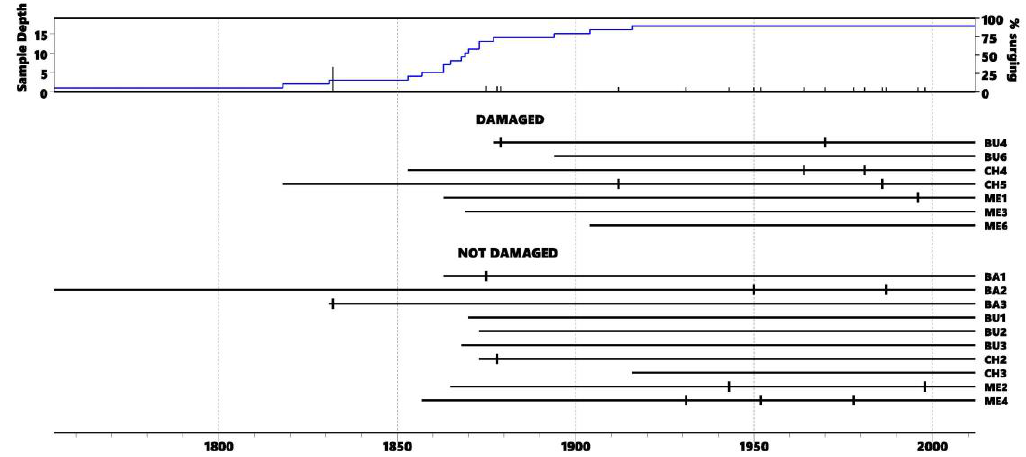
Figure 2. Site-level reconstruction of releases in storm-damaged and -undamaged Picea schrenkiana stands in southeast Kazakhstan. The bottom chart records events in which growth releases initiated in 2 or more trees on a given plot within a 5-yr period. The top chart records the number of plots in the chronology at any given time (blue) and the percent of plots recording the growth release (histogram, composited from the bottom chart). BA is Bolshaya Almatinka, BU is Butakovka Valley, CH is Chimbulak, and ME is Medeu Ski Valley.